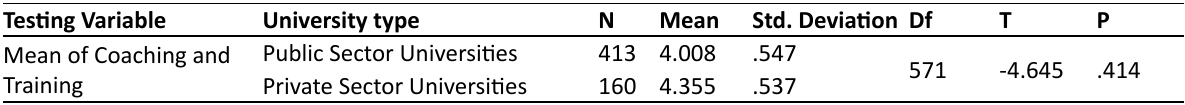
Table 4. Showing mean difference between the perception of public and private sector universities respondents regarding the effect of Coaching and training as factor upon sport performance of the athletes in KP, Pakistan Testing Variable